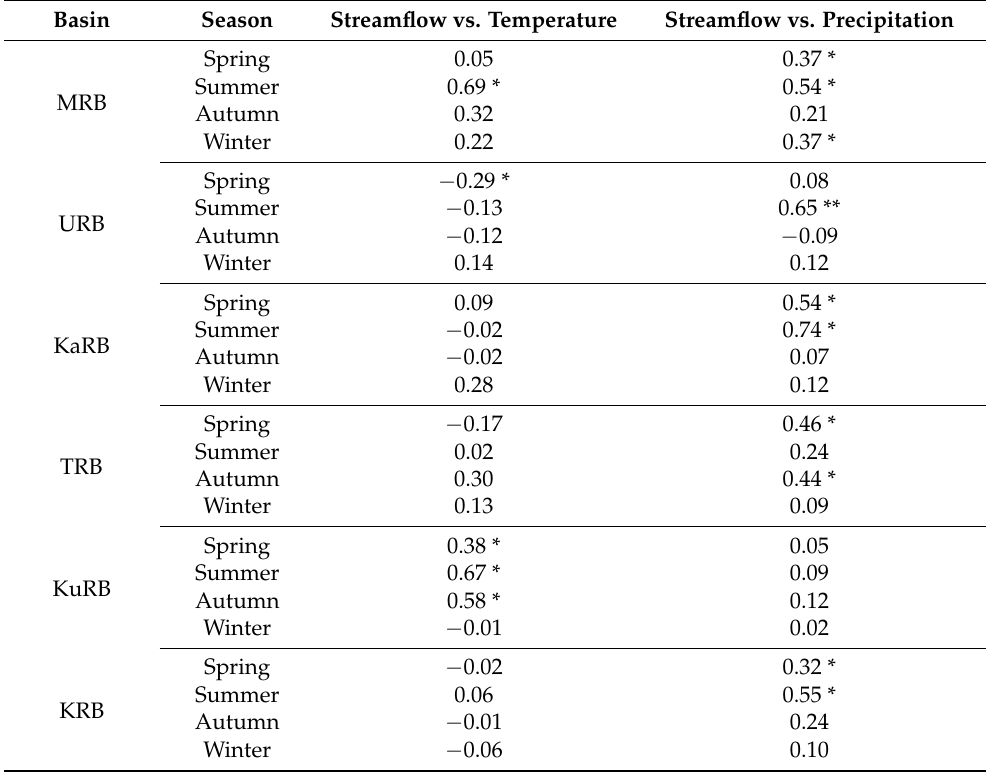
Table 1. Seasonal correlation coefficients between climate and runoff.